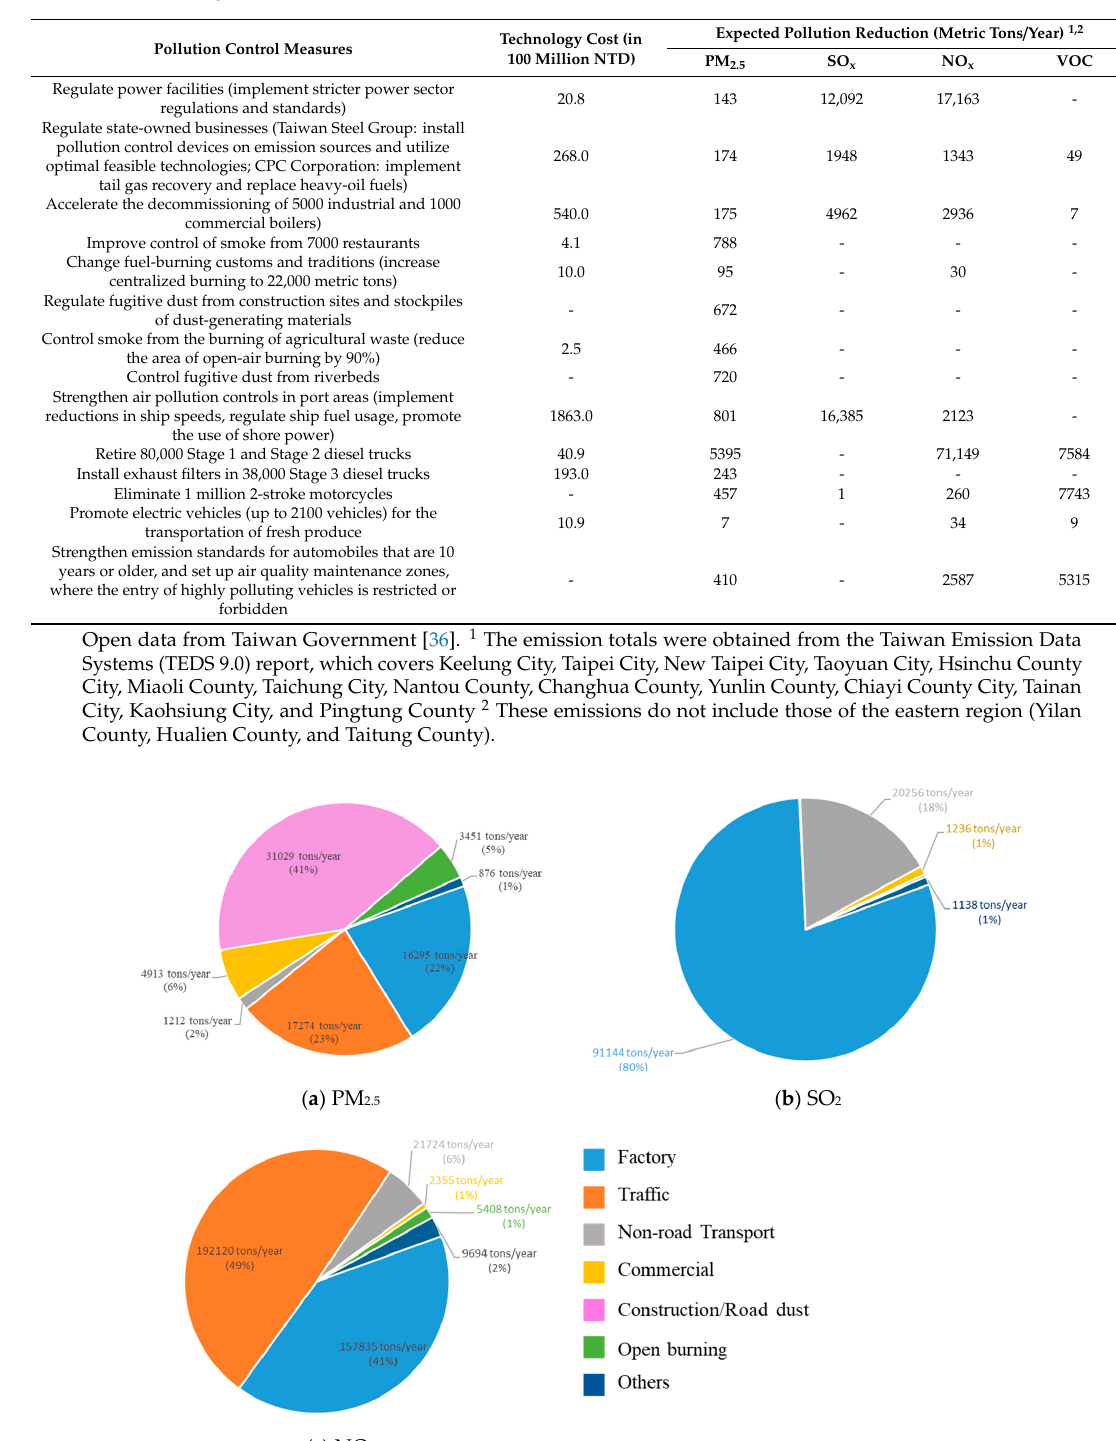
Table 1. Expected pollution reduction of each pollution control measure with the 14 air pollution control strategies (TAPCAP).